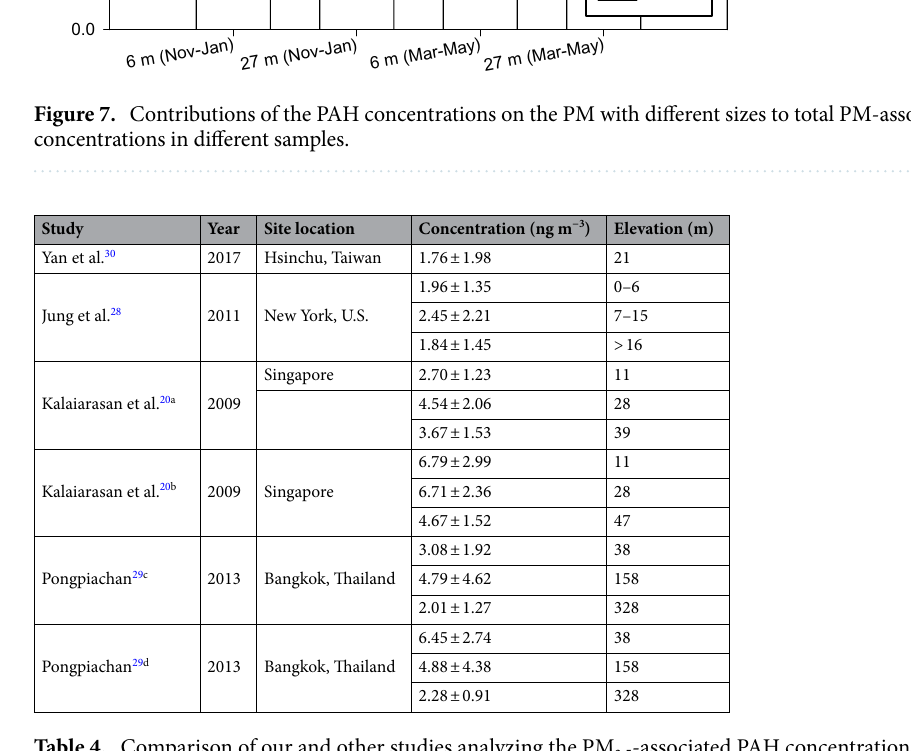
Table 4. Comparison of our and other studies analyzing the PM 2.5 -associated PAH concentrations. a The study was carried out at a building of point block configuration. b The study was carried out at a building of slab block configuration. c The study analyzed the concentrations during the daytime. d The study analyzed the concentrations during the